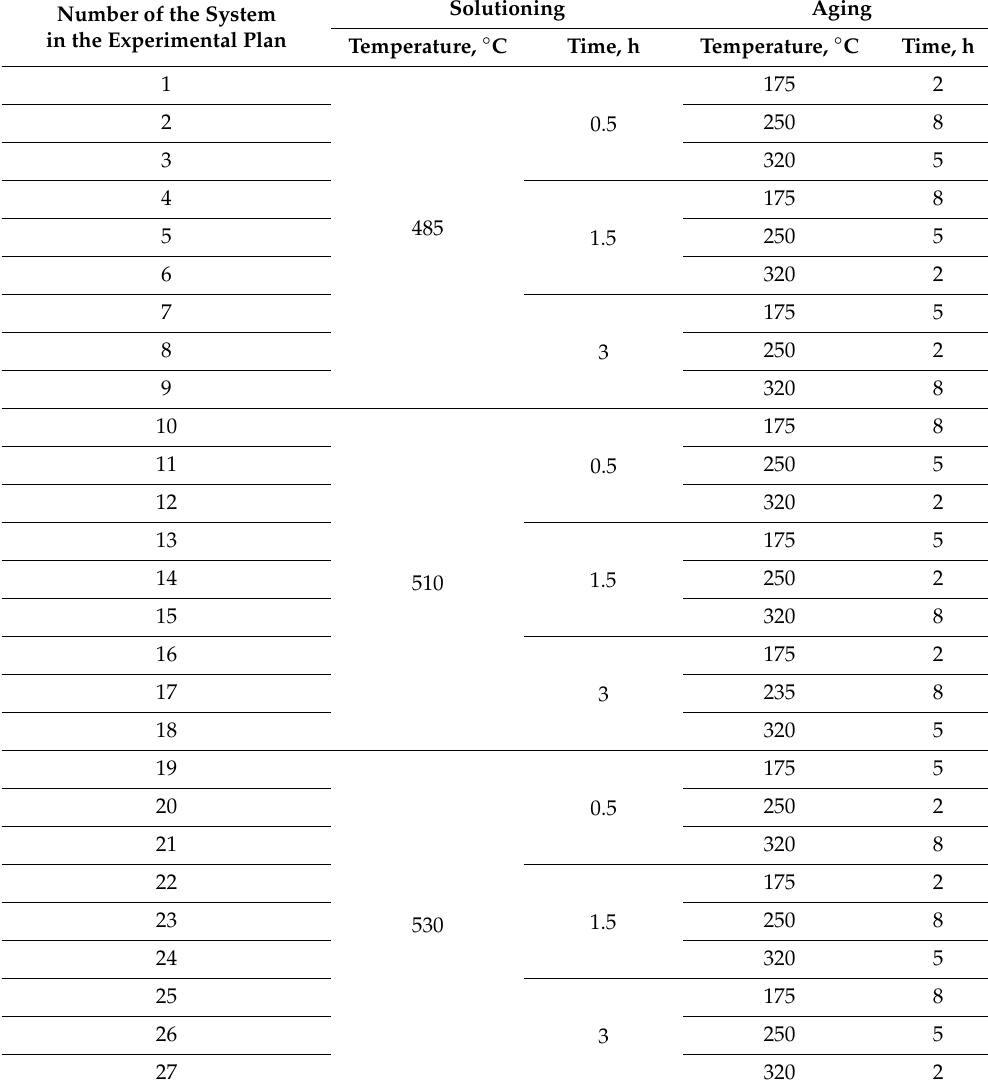
Table 2. Investigations plan of the heat treatment of the EN AC-AlSi7Cu3Mg